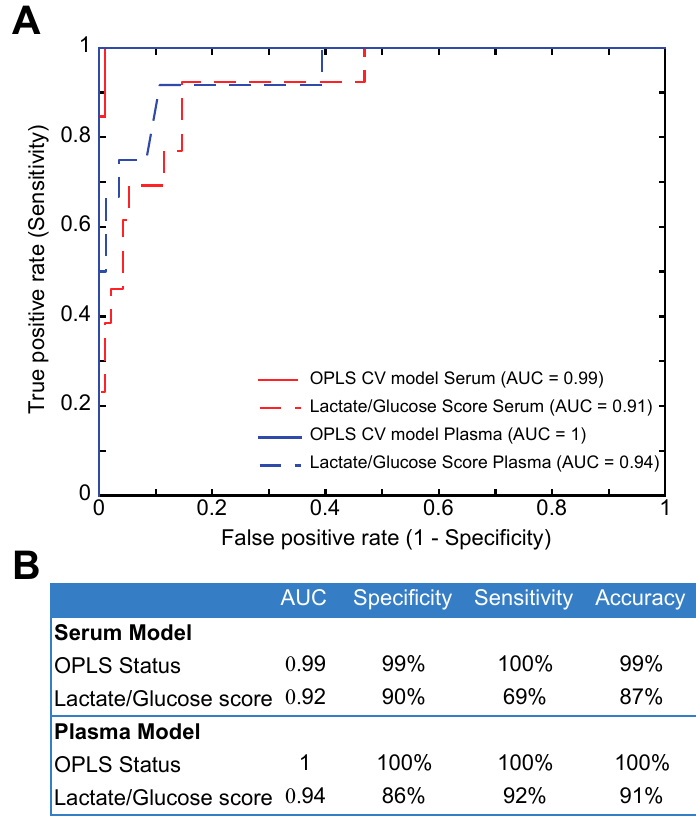
Figure 3. ROC curves analyses. ( A ) Receiver operating characteristics (ROC) analyses including OPLS cross-validated (CV) status and a lactate/glucose ratio for serum and plasma cohort; ( B ) Area under the curve (AUC), specificity, sensitivity and accuracy of the ROC models.